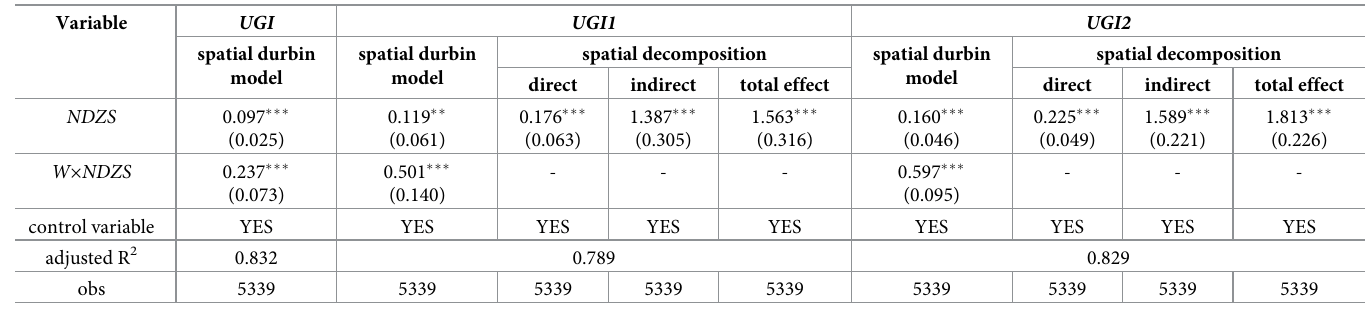
Table 9. Robustness check: Removing four metropolises.